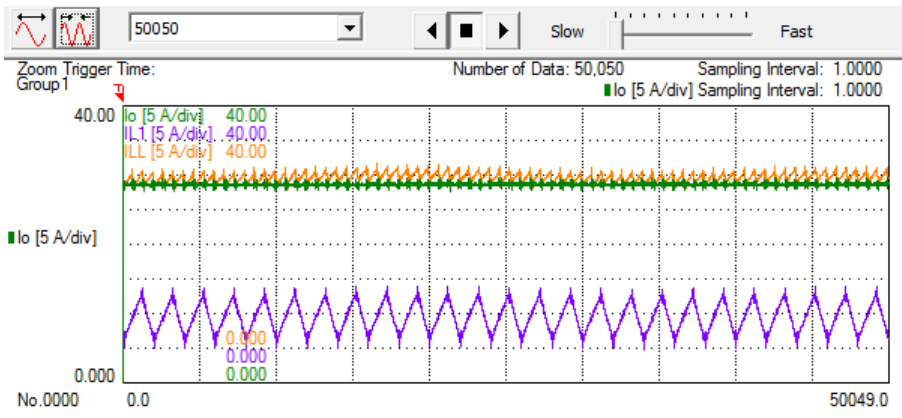
Figure 24. Phase-1 current, reduced-ripple output current and load